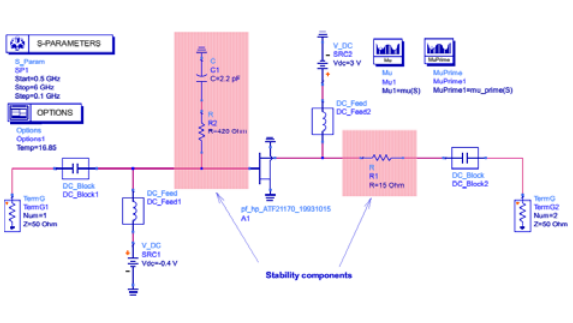
Fig. 2. The proposed stability components